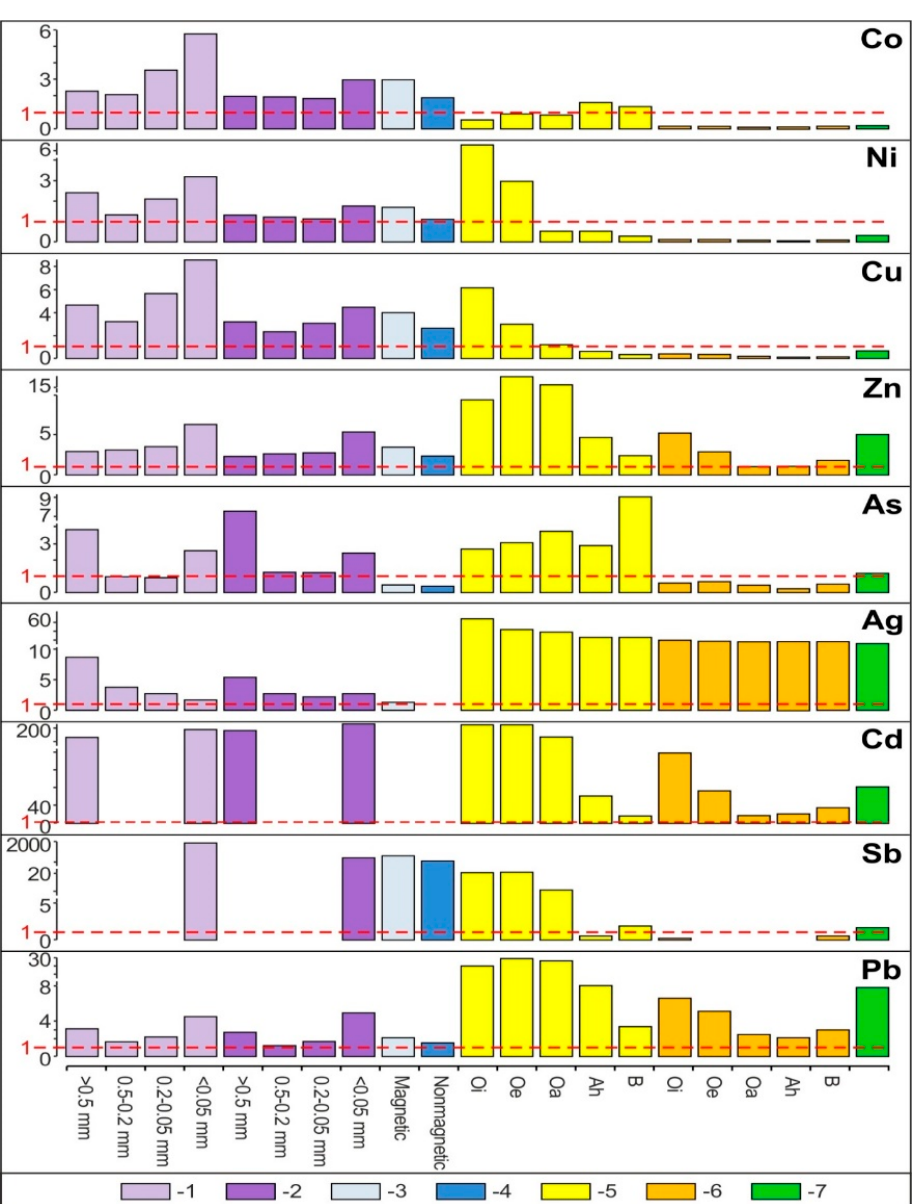
Figure 5. Enrichment factor of the fly ash, slag, topsoil and roots compared to feed coal.Fly ash: 1—magnetic fractions, 2—nonmagnetic fraction; 3 and 4—slag; topsoil: 5—magnetic fraction, 6— nonmagnetic fraction; 7—roots.